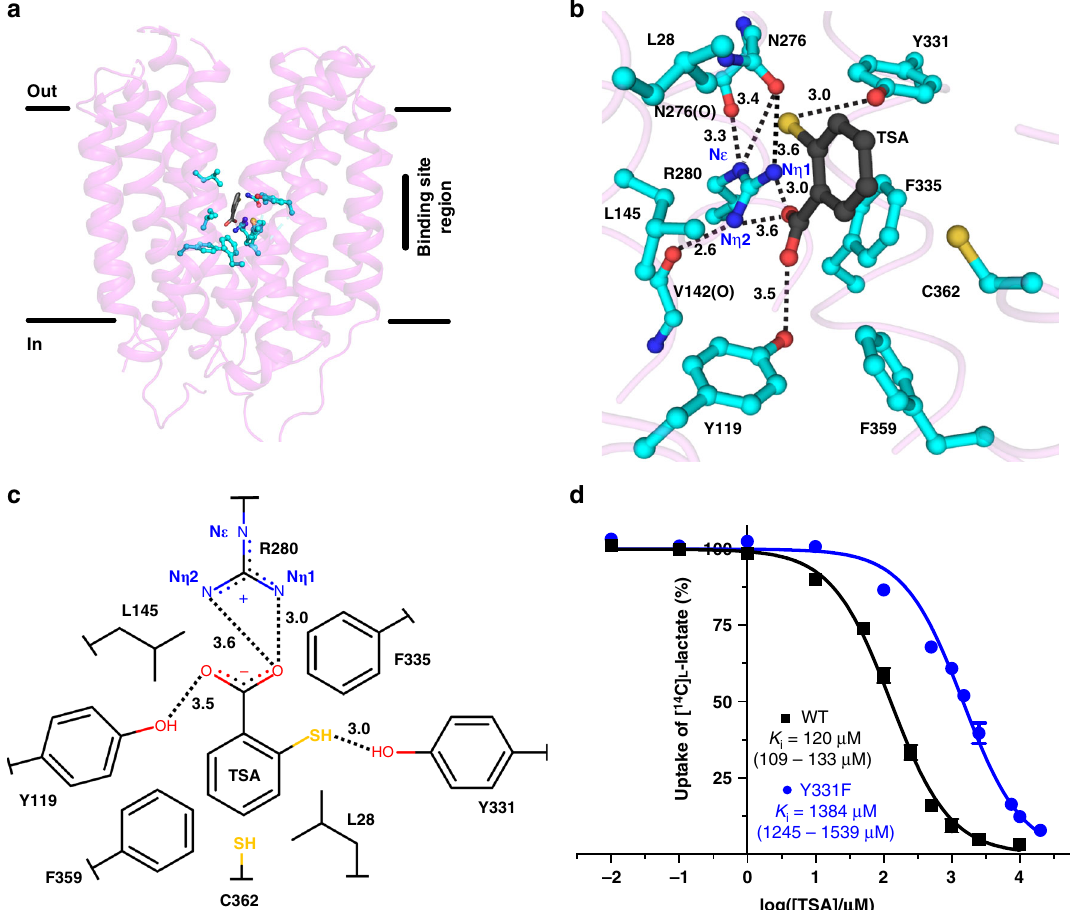
Fig. 3 Binding pocket of SfMCT with bound TSA. a Overall structure of SfMCT in the outward-open conformation viewed in the plane of the membrane with indicated TSA (black) and binding site residues (cyan). b Binding mechanism of TSA to SfMCT. Residues within a distance of 4 Å from TSA, N276 and the peptide backbone of V142 are displayed as ball-and-stick model and are highlighted in cyan. c Two-dimensional schematic representation of key residues that are involved in TSA-binding. Distances in ( b , c ) are given in Ångström (Å). d K i determination of wild-type (WT) and Y331F SfMCT for TSA. The determined K i values are 120 μ M (95% con fi dence interval: 109 – 133 μ M) for WT and 1384 μ M (95% con fi dence interval: 1245 – 1539 μ M) for Y331F. Data are represented as mean ± SEM from three independent experiments, each in triplicate. Source data are provided as a Source Data fi le